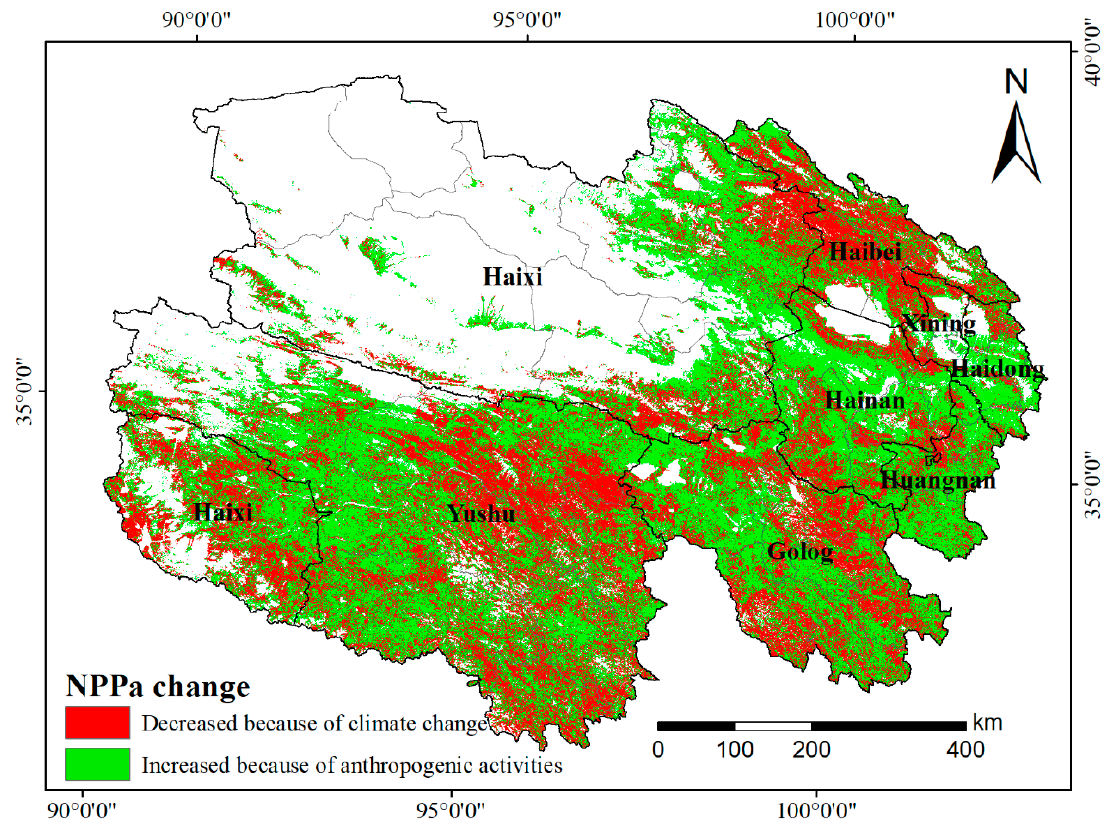
Figure 8. Spatial patterns of driving factors for NPP a changes in alpine grassland in Qinghai Province from 2005 to 2018.